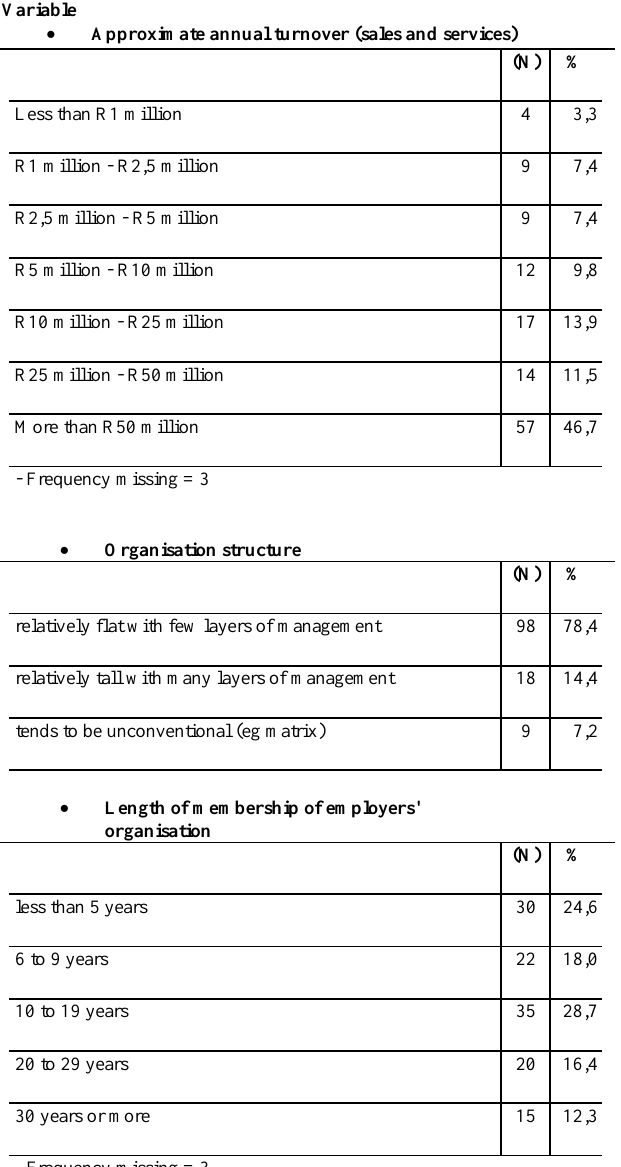
Table 2: Characteristics of participating